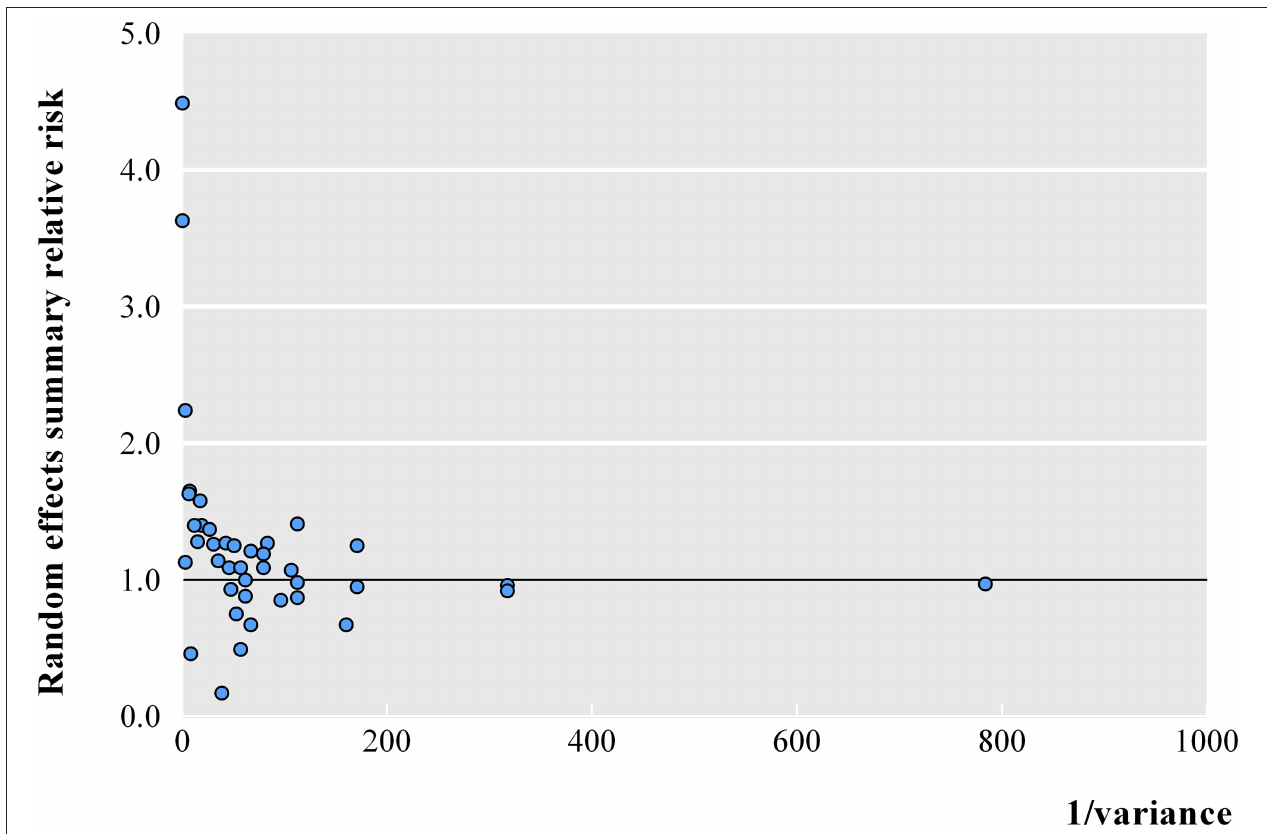
FIGURE 2 | The association of meta-analysis summary effect sizes with the inverse of the variance.